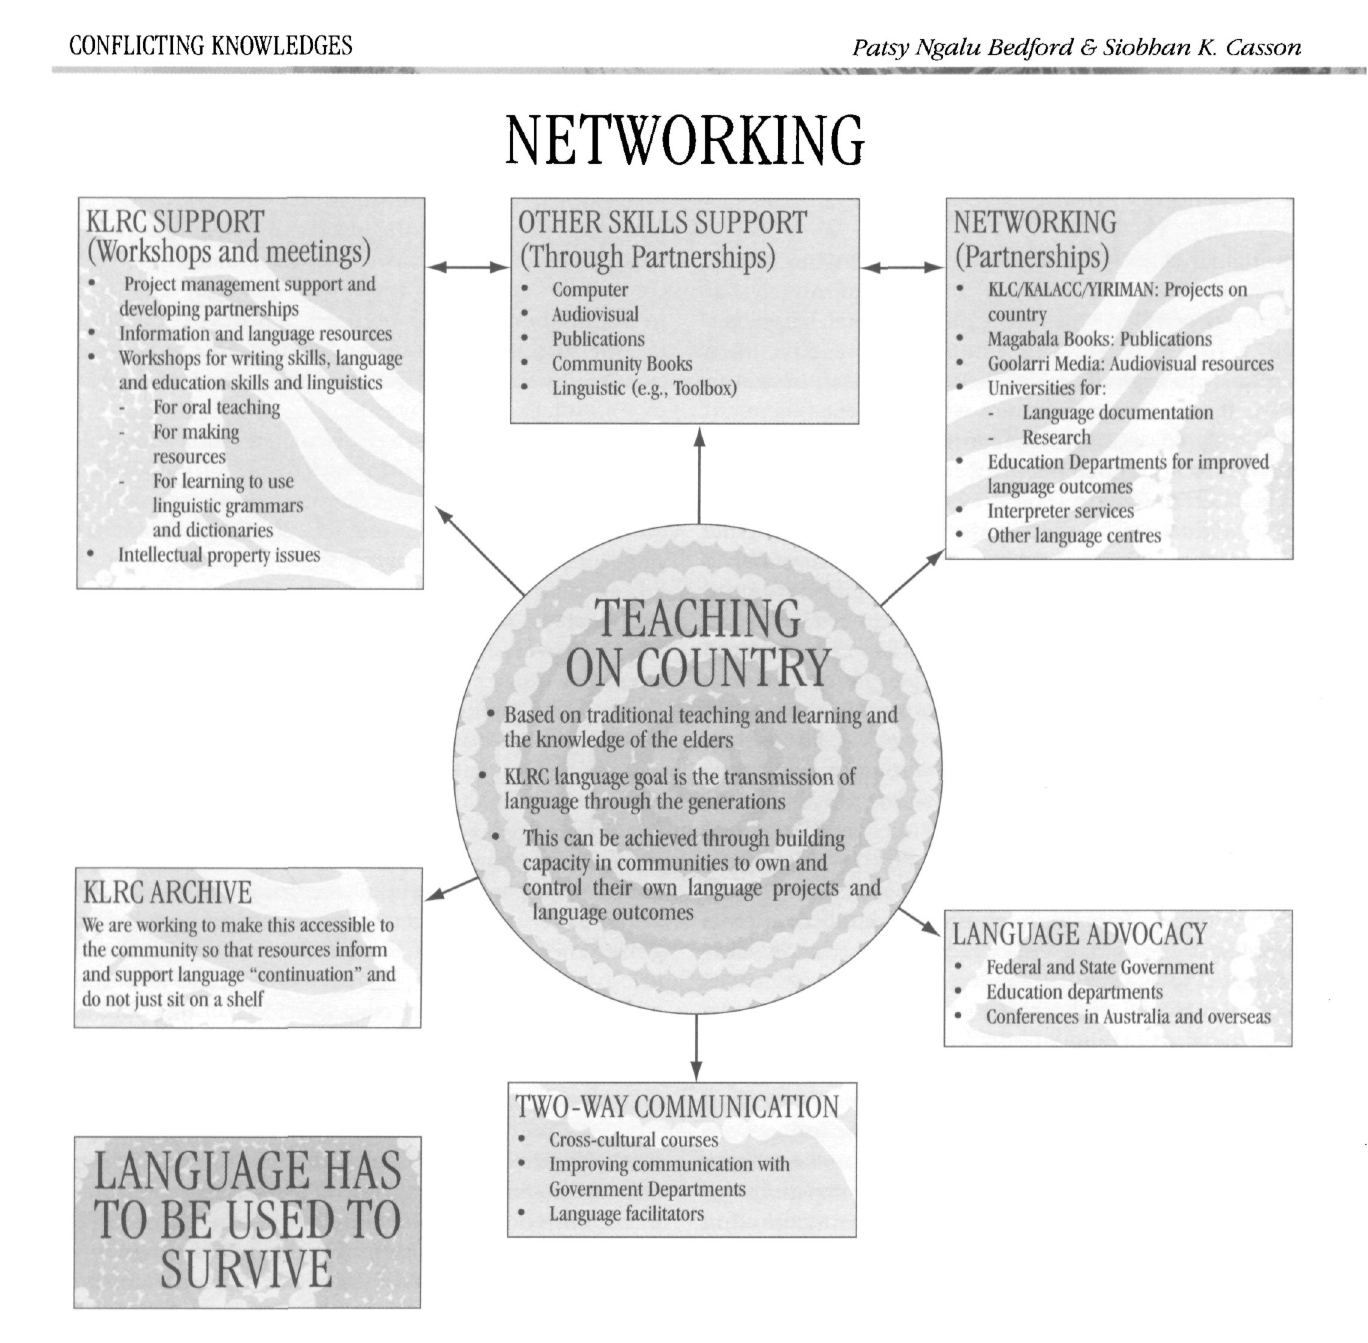
Figure 1: Networking model to support the aims of the Kimberley Language Resource